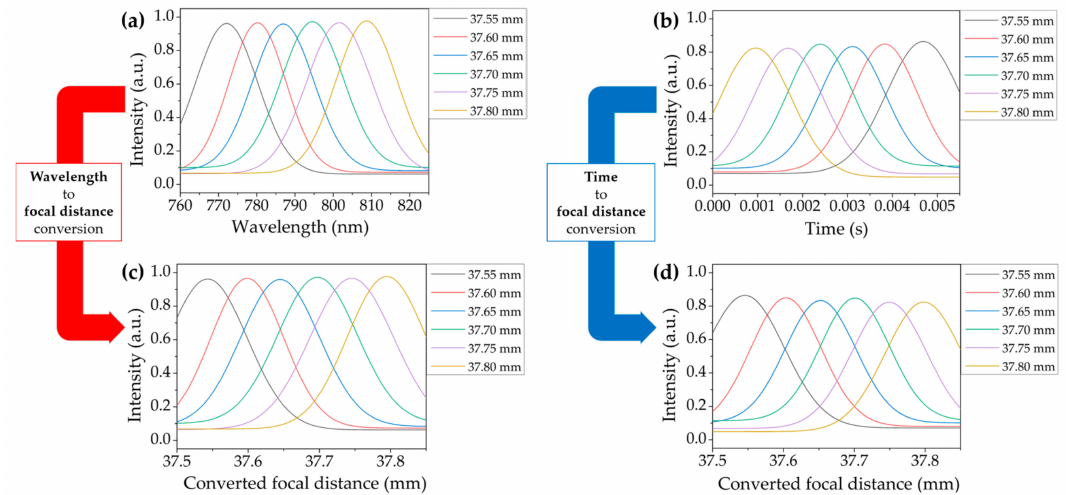
Figure 3. Measuredintensitydistribution( a )asafunctionofthewavelengthobtainedusingtheconventional CCM and ( b ) as a function of time obtained using the SS-CCM system. The converted information of the focal distance shift is shown in ( c ) for the conventional CCM and ( d ) for the SS-CCM